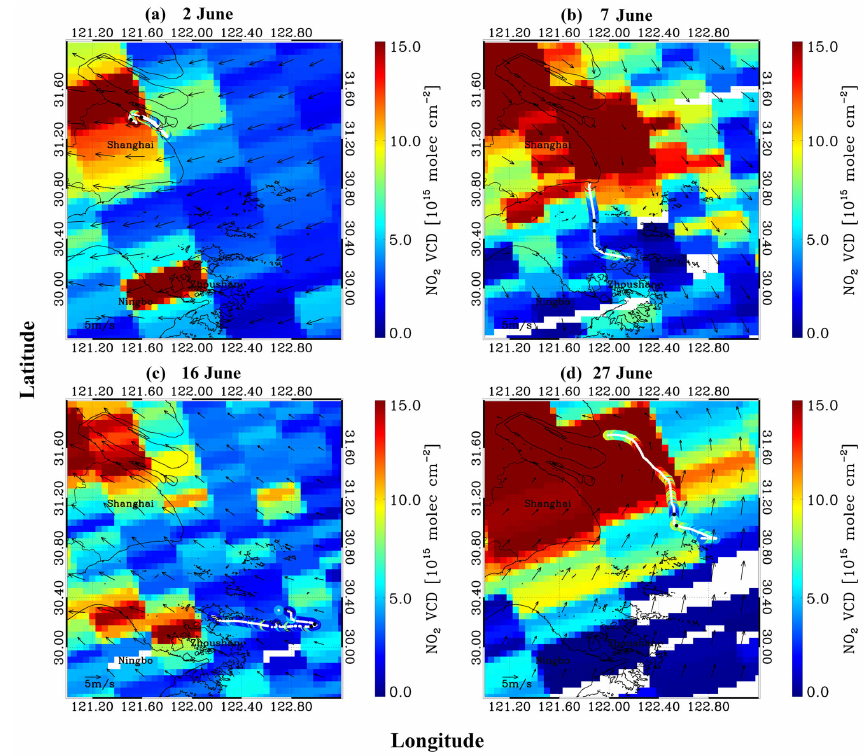
Figure 10. Comparison of OMI and ship-based measurements of NO 2 VCDs on (a) 2, (b) 7, (c) 16, and (d) 27 June. The ship-based measurements were plotted overlapping the base map of OMI products, and the wind field is indicated with black arrows.